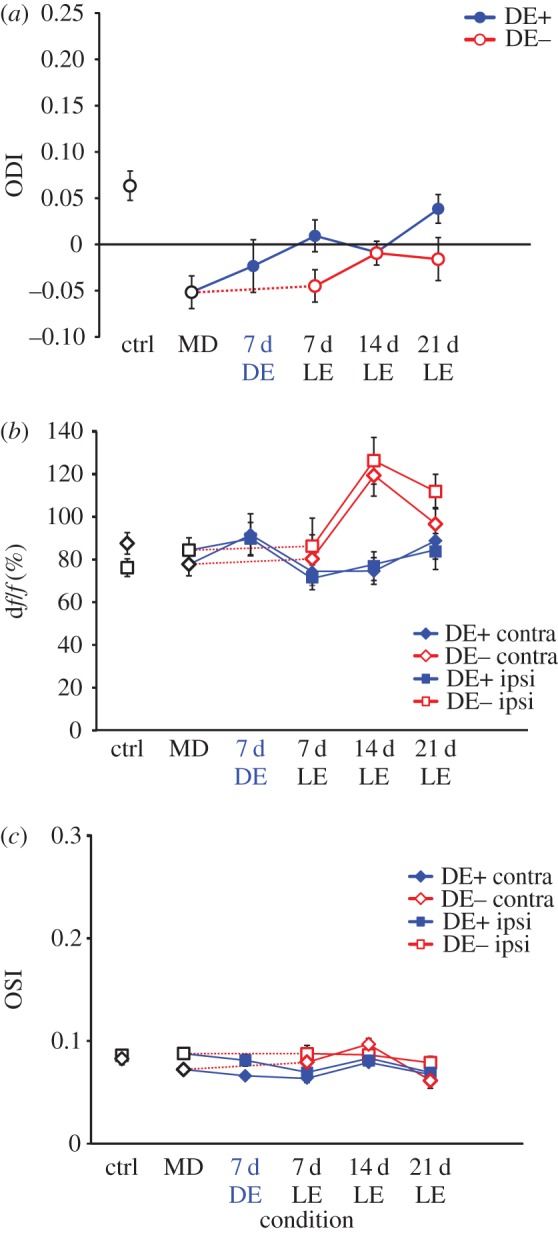
Population responses of PV+ inhibitory neurons in control animals, in monocularly deprived mice, and during recovery from MD. (a) Ocular dominance index; open red circles represent data from DE− mice, filled blue circles represent data from DE+ mice. (b) Magnitude of neuronal responses through the contralateral eye (diamonds) and the ipsilateral eye (squares) in control, DE+ and DE− mice. (c) Orientation selectivity index of neuronal responses through the contralateral eye (diamonds) and the ipsilateral eye (squares) in control, DE+ and DE− mice.